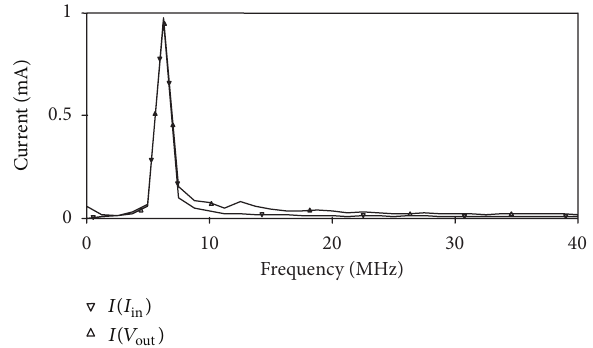
Figure 6: Fourier spectrum of the input and output.